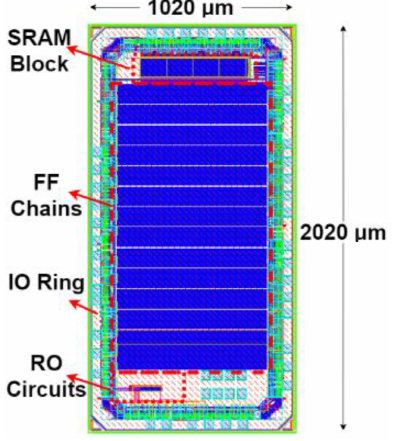
Figure 5. Test chip overall layout.